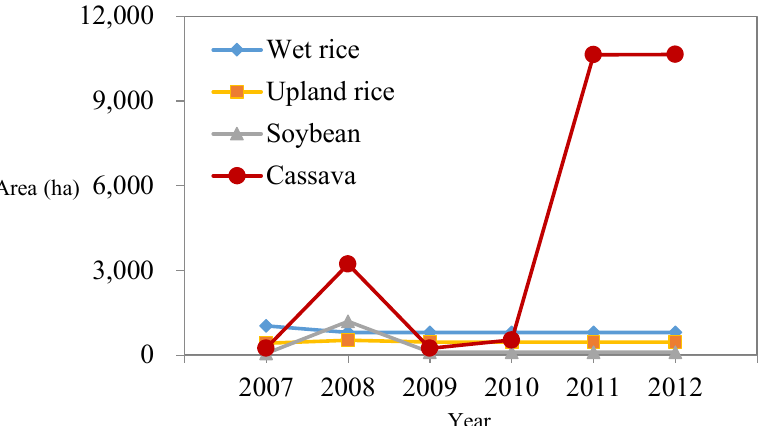
Figure 3. Changes in the areas of cultivation of four main crops in the commune where the research site is